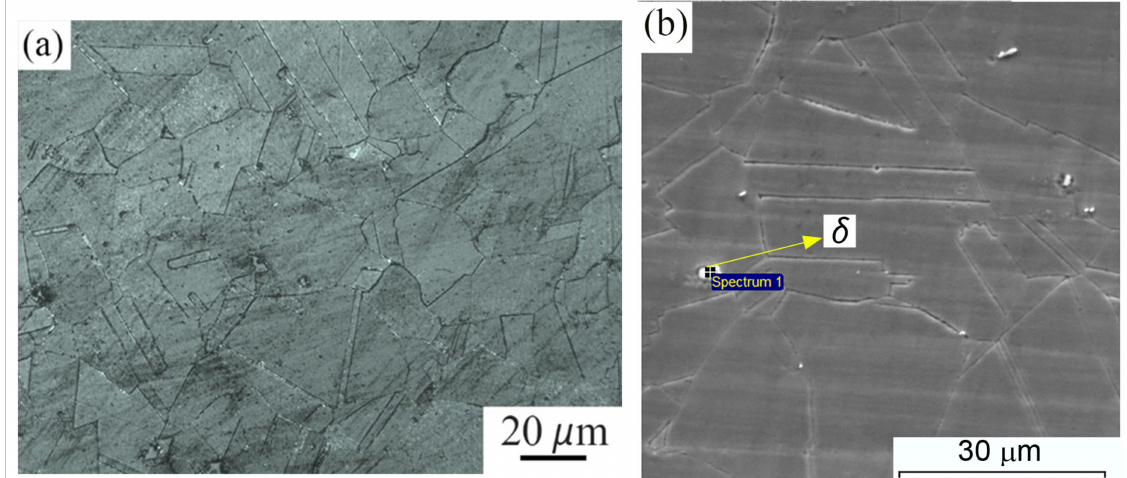
Figure 5. ( a ) Optical micrograph of the IN718 solution-treated and aged (STA) base metal, ( b ) SEM Figure 4. ( a ) Optical micrograph of the IN718 solution-treated (ST) base metal, ( b ) SEM micrograph showing ծ -based precipitates, and ( c ) a typical EDS precipitate spectrum . micrograph showing -based Figure 5a,b show optical and scanning electron micrographs of IN718 STA base metal, respectively. The micrographs revealed equiaxed grains with annealing twins, and the average grain size of the IN718 STA alloy was 24 ± 7 µm. Figure 5b also shows numer- ous randomly dispersed δ (Ni 3 Nb) fi ne particles at the grain boundaries and within the grains. When comparing the microstructures of the IN718 ST and IN718 STA, it was ob- served that the grain size of the IN718 STA samples was coarser, due to prolonged expo- sure to high temperatures and the sluggish nature of the γ ’’ precipitation process during aging.